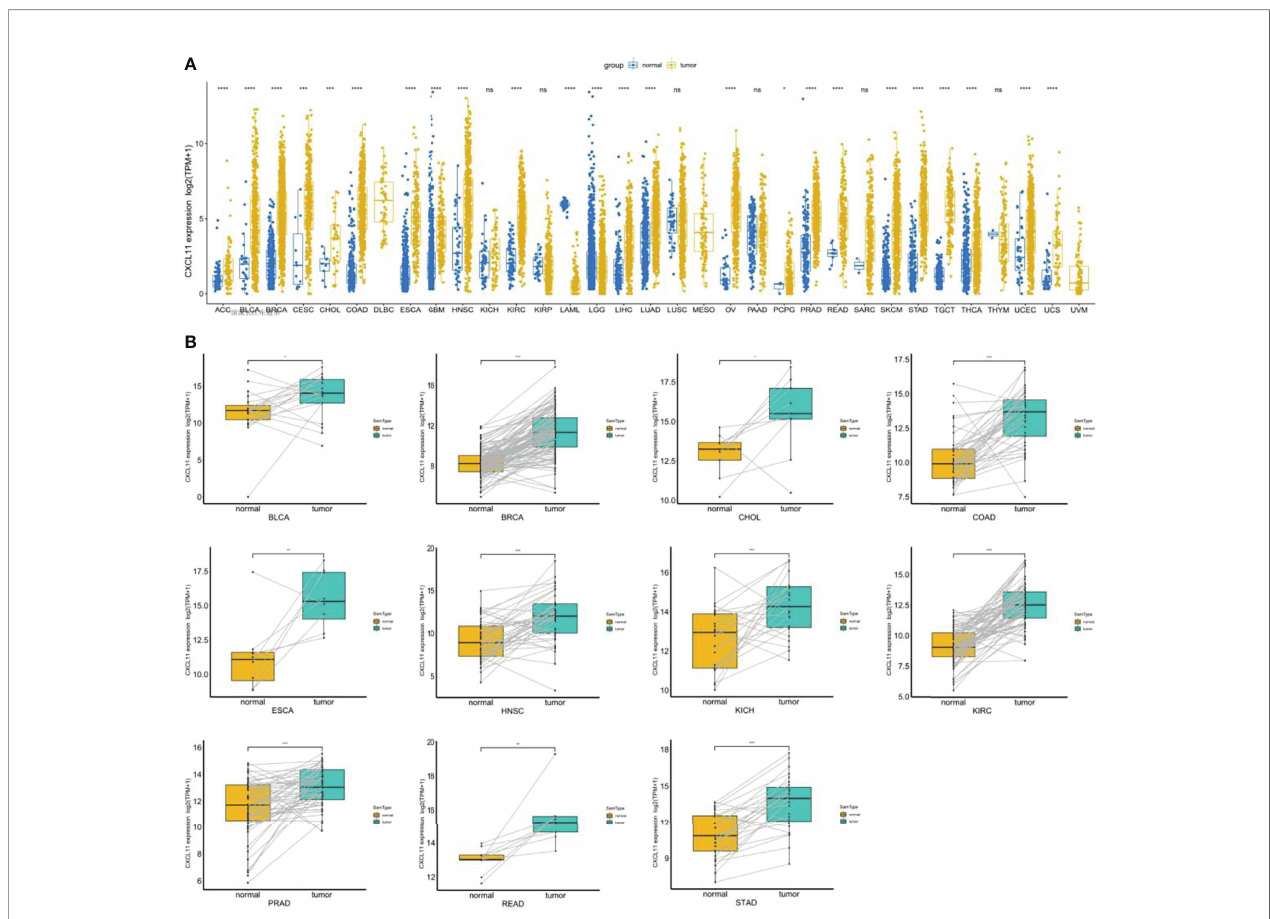
FIGURE 1 | CXCL11 pro fi le across cancers. (A) The expression of CXCL11 across normal and tumor tissues in the integrated GTEx database and TCGA database. (B) According to TCGA data, the levels of CXCL11 in corresponding tumors and normal tissues in BLCA, BRCA, CHOL, COAD, ESCA, HNSC, KICH, KIRC, PRAD, READ, and STAD. ns denotes not statistically signi fi cant, *p < 0.05, **p < 0.01, ***p <0.001, ****p <